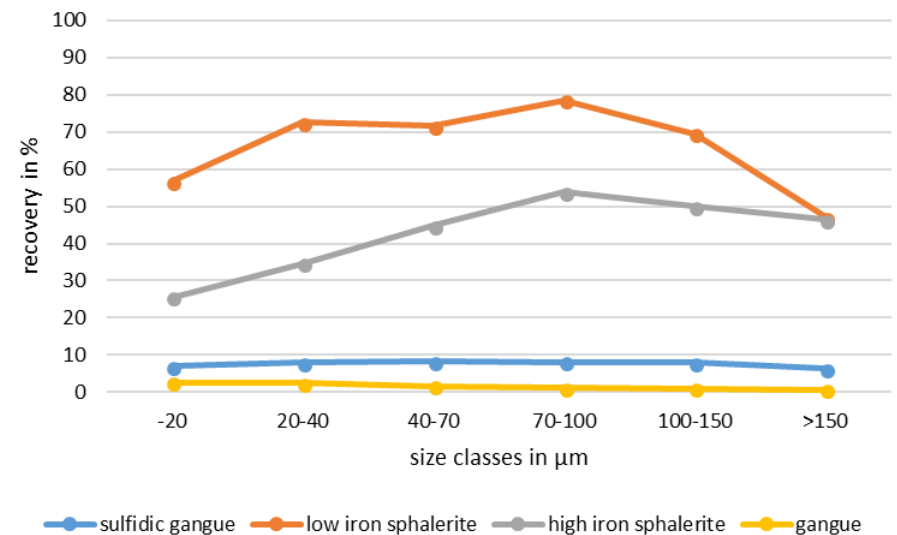
Figure 7. Recovery by size classes for grouped minerals of B1_TP_1.